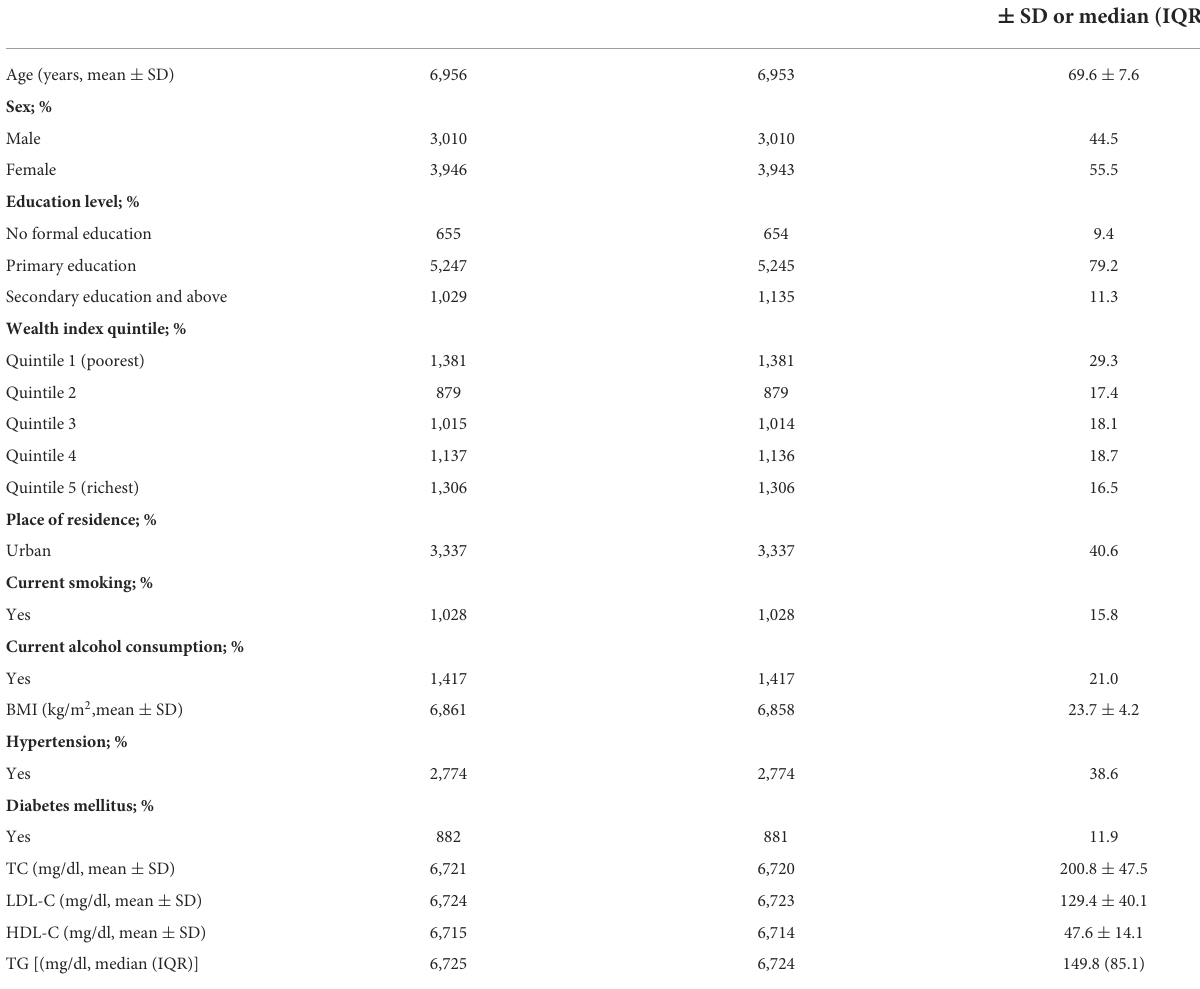
TABLE 1 Characteristics of the study populations.